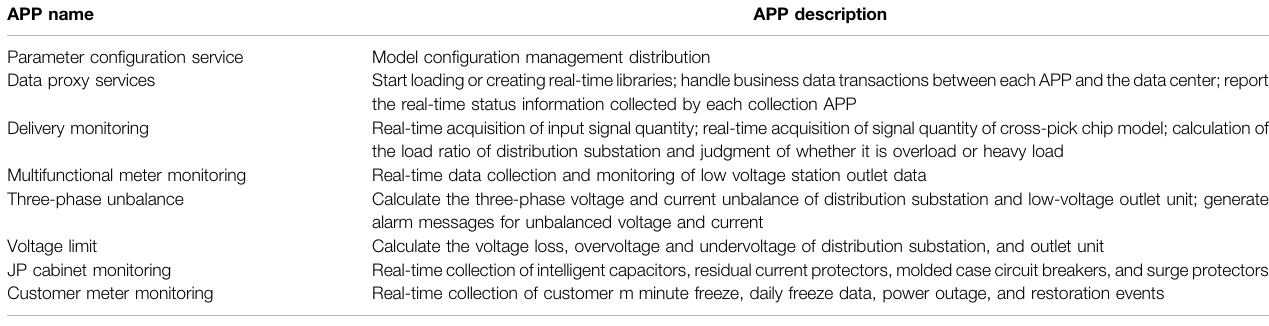
TABLE 1 | Fusion terminal APP.